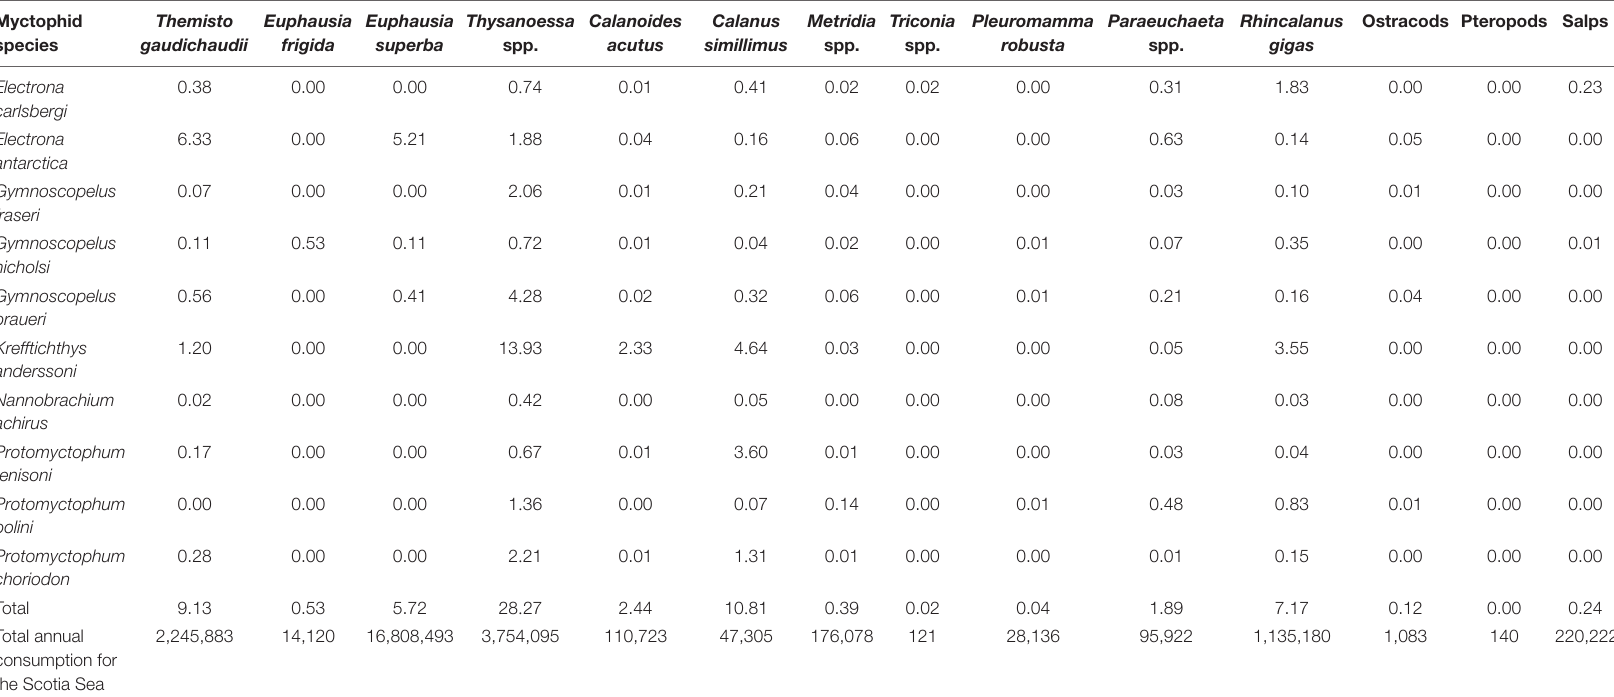
TABLE 6 | Best (median) estimates of the overall impact of myctophid predation on the productivity of their main zooplankton prey taxa in the Scotia Sea, expressed as a percentage of the daily production consumed ( µ g C m − 1 day − 1 ) by each myctophid species.